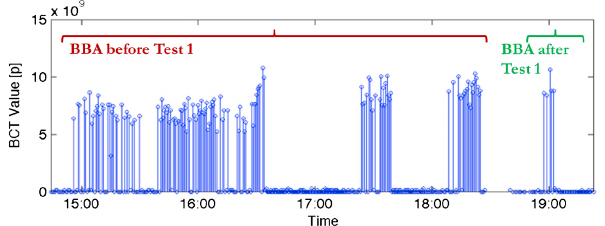
FIG. 8. Low-intensity SPS pilot beam extraction intensities used for the beam-based alignment (BBA) before and after Test 1.